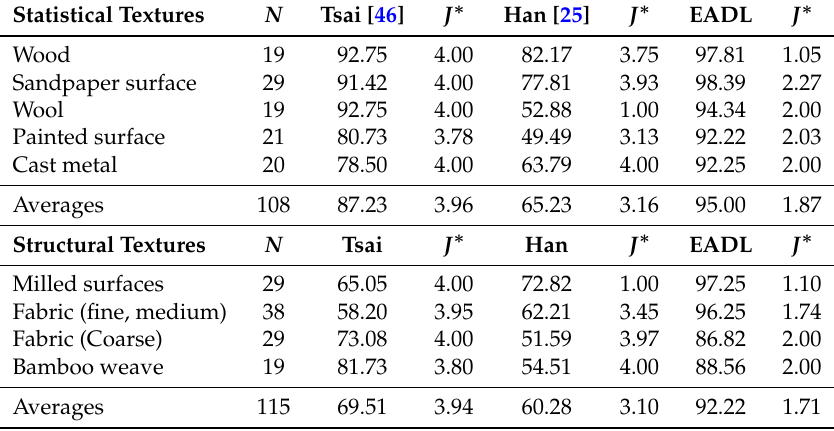
Table 7. Yield values in defect